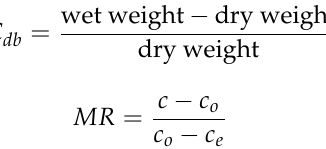
Figure 7. The computational velocity and temperature field and moisture concentration in the bean under a constant temperature drying condition of 50 °C at 240 min after drying started: ( a ) the velocity field (m/s) around the bean with a freestream flow velocity of 1 m/s; ( b ) the temperature field (K) in the solid (shell and core) and the fluid flow domain; ( c ) the dry basis moisture concentration field (mol/m 3 ) inside the cocoa bean at 240 min.